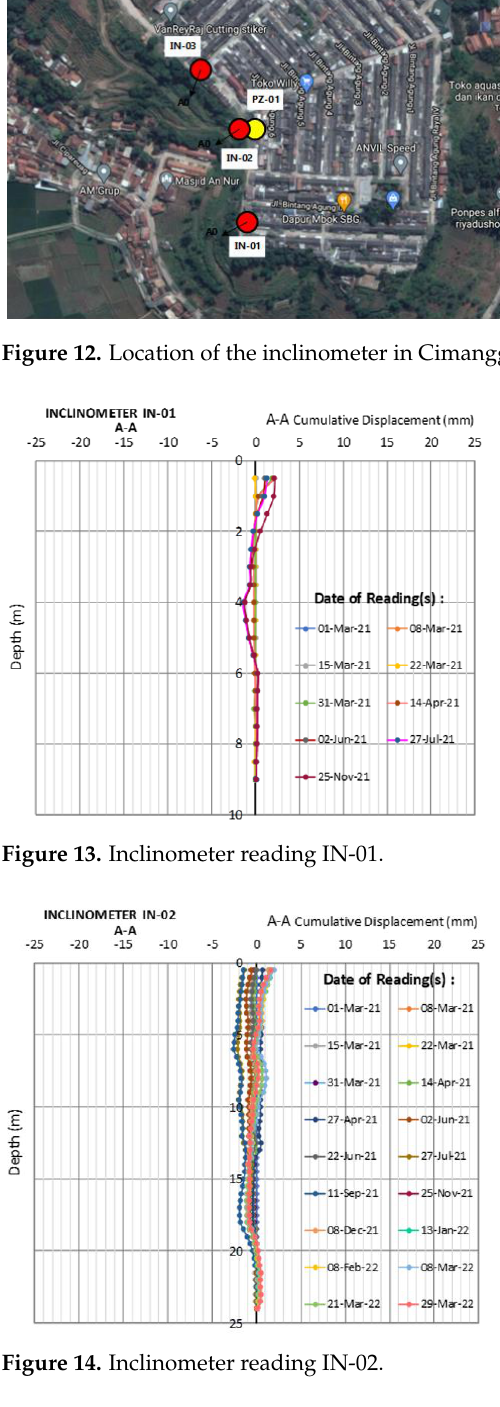
Figure 14. Inclinometer reading IN-02.